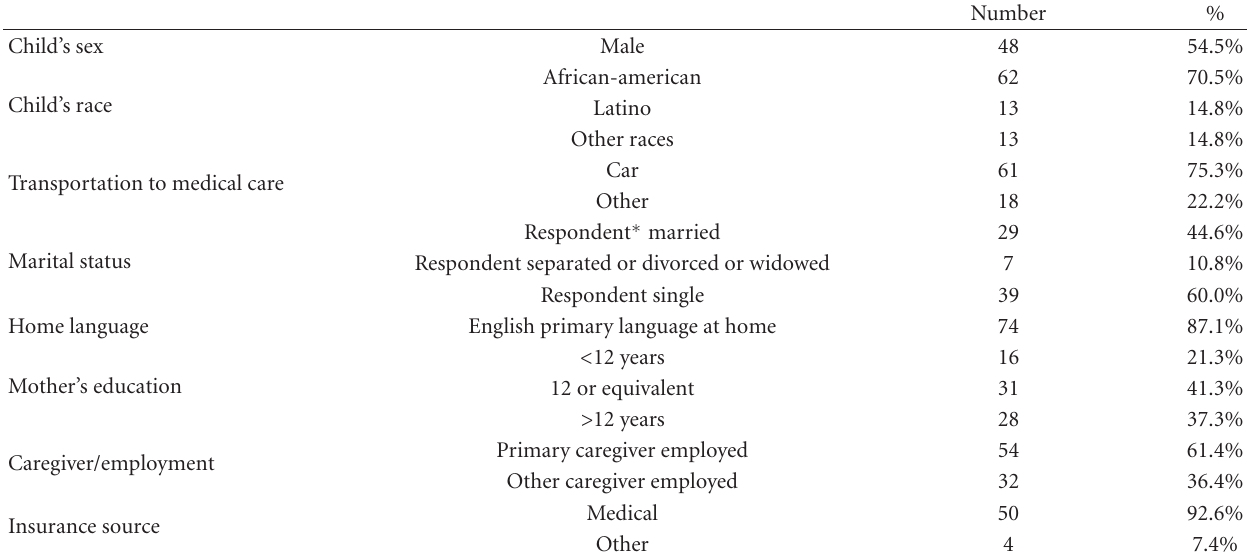
Table 1: Study subject characteristics.